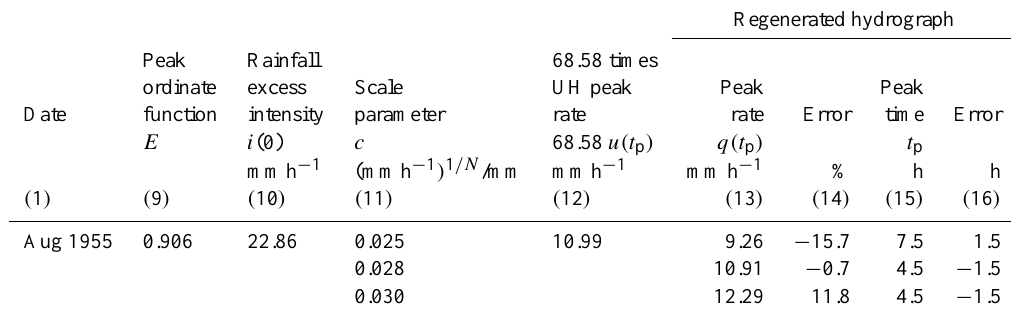
Table 3b. 3-hour unit hydrograph data for Naugatuck River. Calibration of the scale parameter and regeneration of peak characteristics by the inverse Bakhmeteff function method of